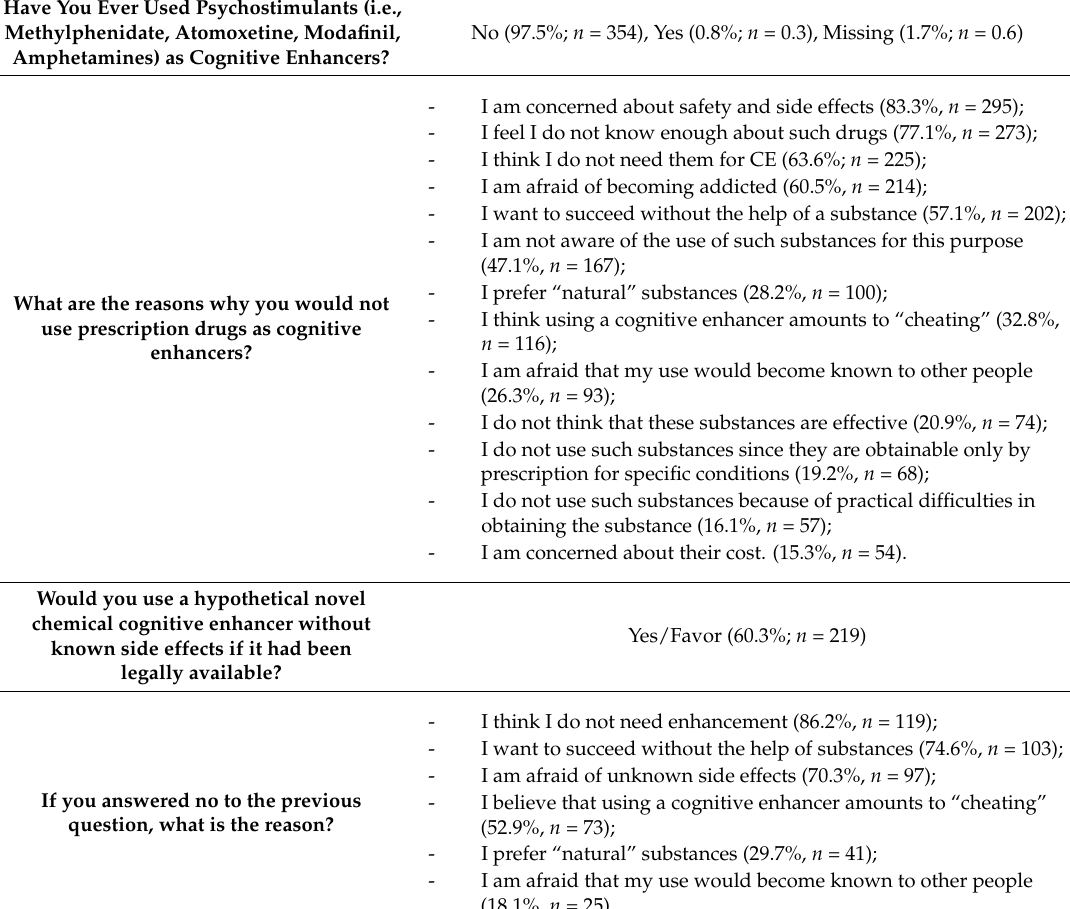
Table 2. Use and reasons for (not) using cognitive enhancers in the